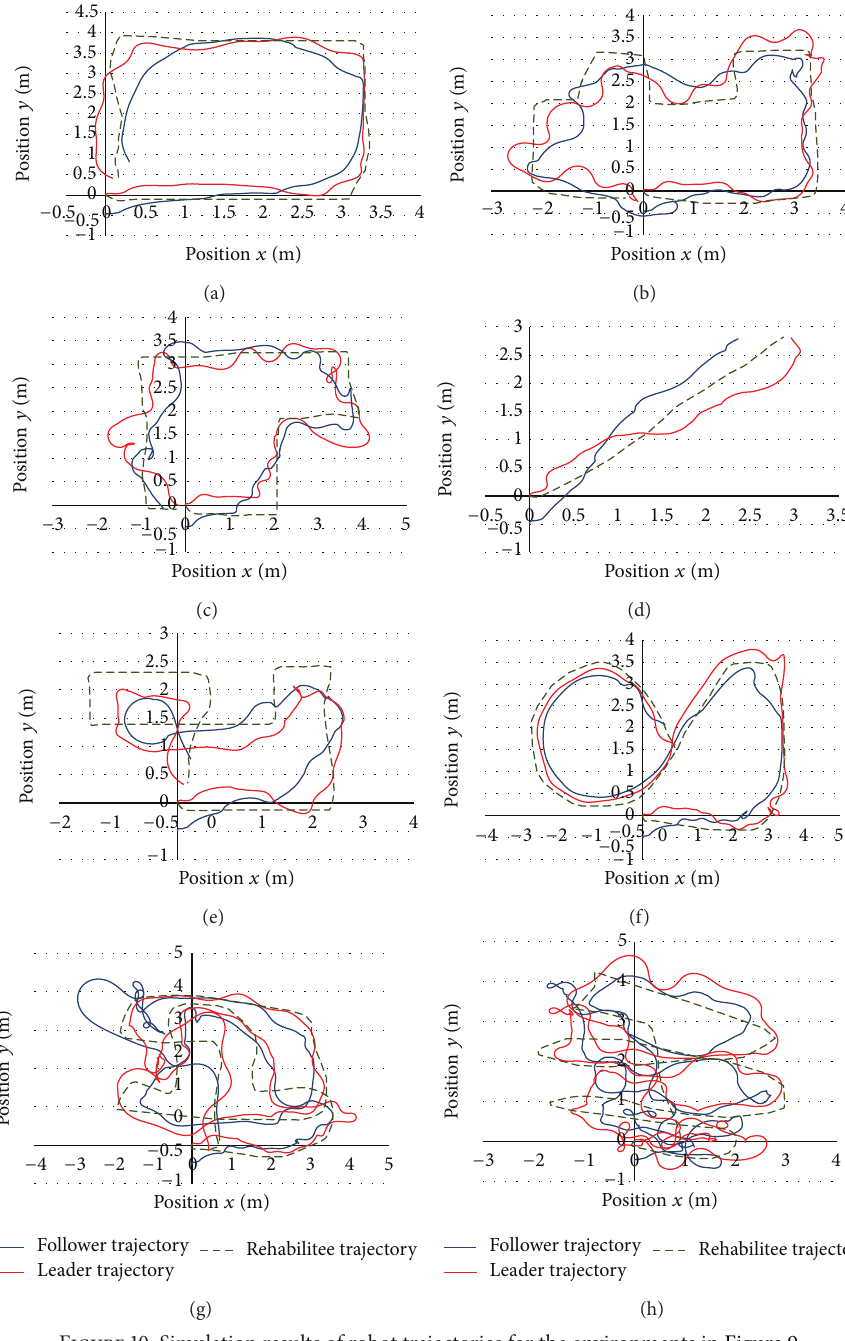
Figure 10: Simulation results of robot trajectories for the environments in Figure